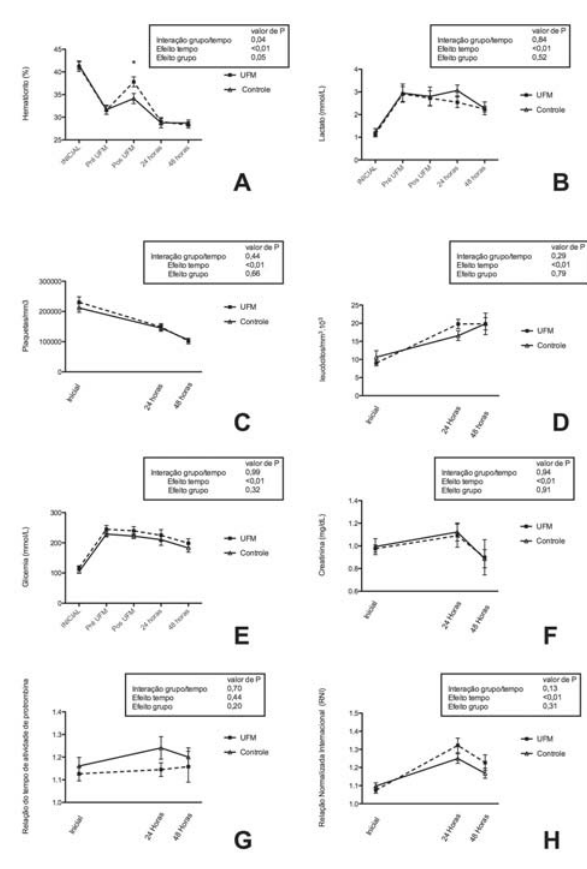
- 2 Fig. 4 - Variáveis hematimétricas, contagem de leucócitos e coagulação. Análise de variância com dois fatores para medidas repetidas. Valores expressos em média e dois erros padrão